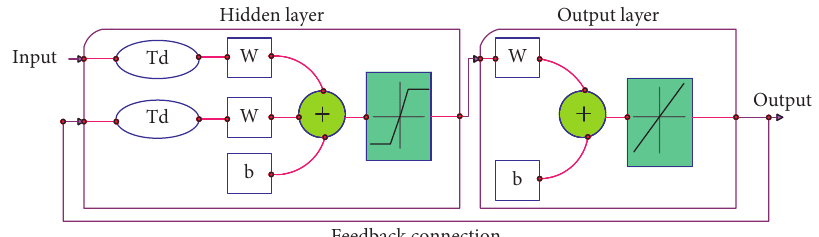
Figure 11: NARX neural network general